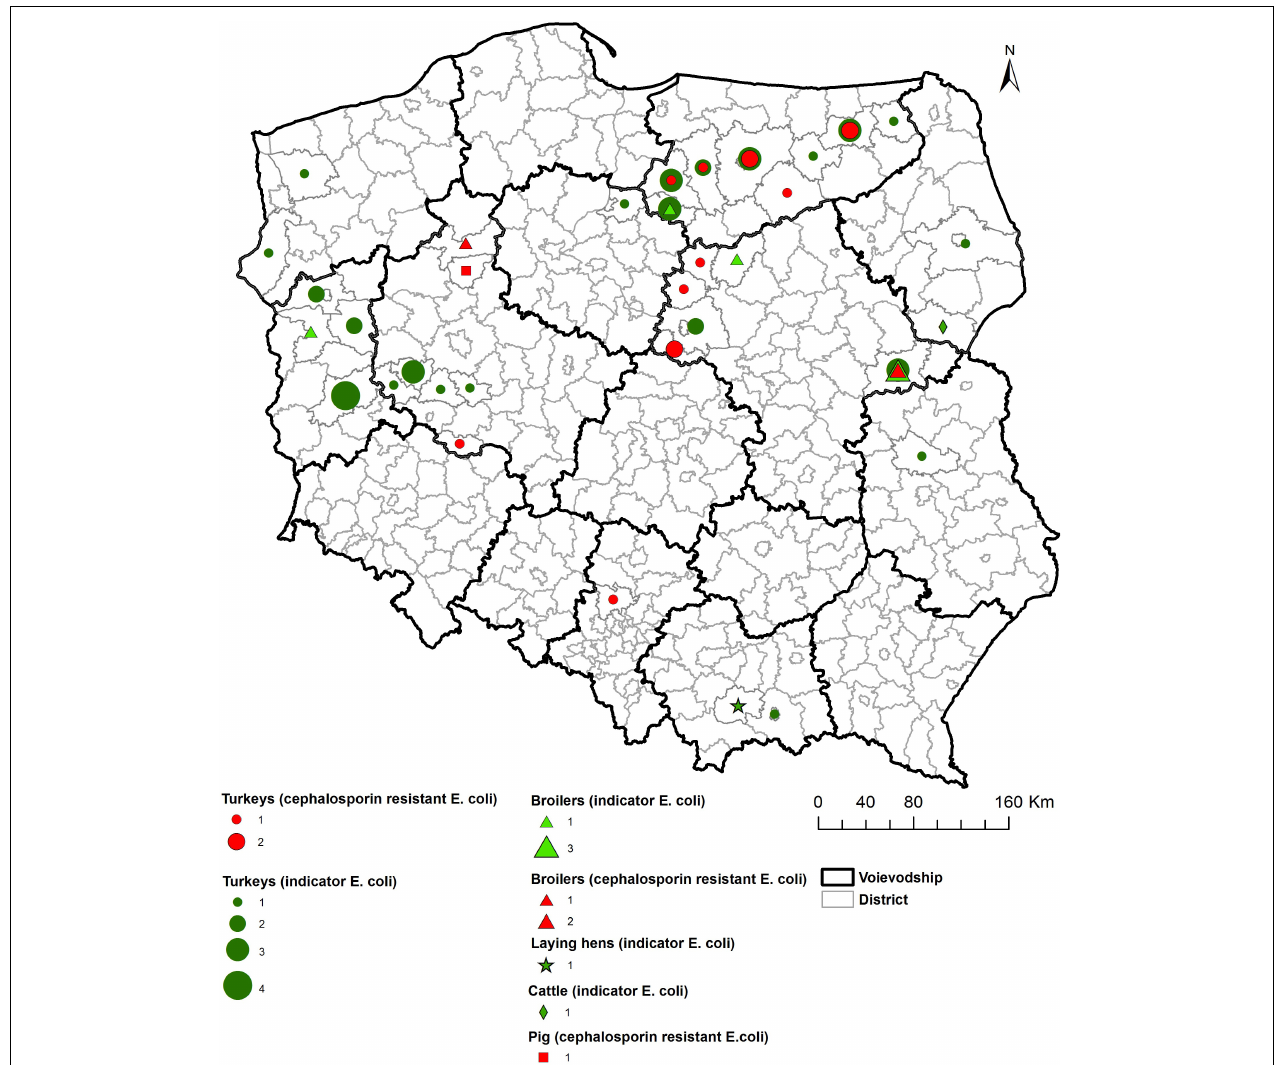
FIGURE 6 | Geographical distribution (district level) of mcr-1 positive E. coli isolation